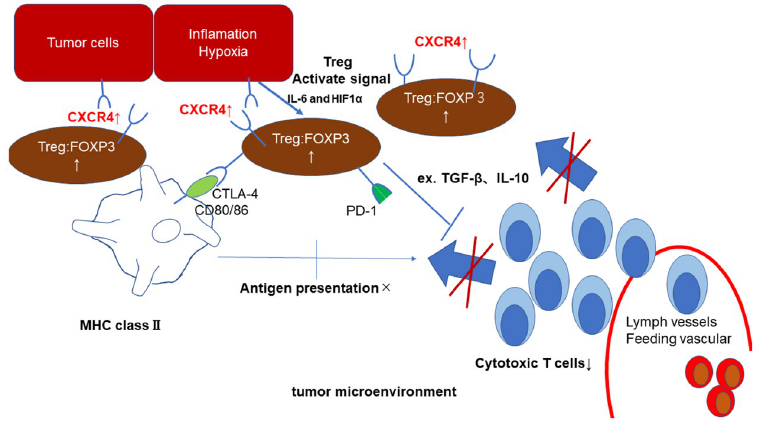
Fig 4. Schematic illustration of hypothetical tumor immunity process in conjunctival squamous cell carcinoma.